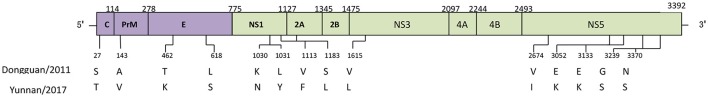
Amino acid mutations between CDS of Dongguan strain (2011) and Yunnan strains (2017).